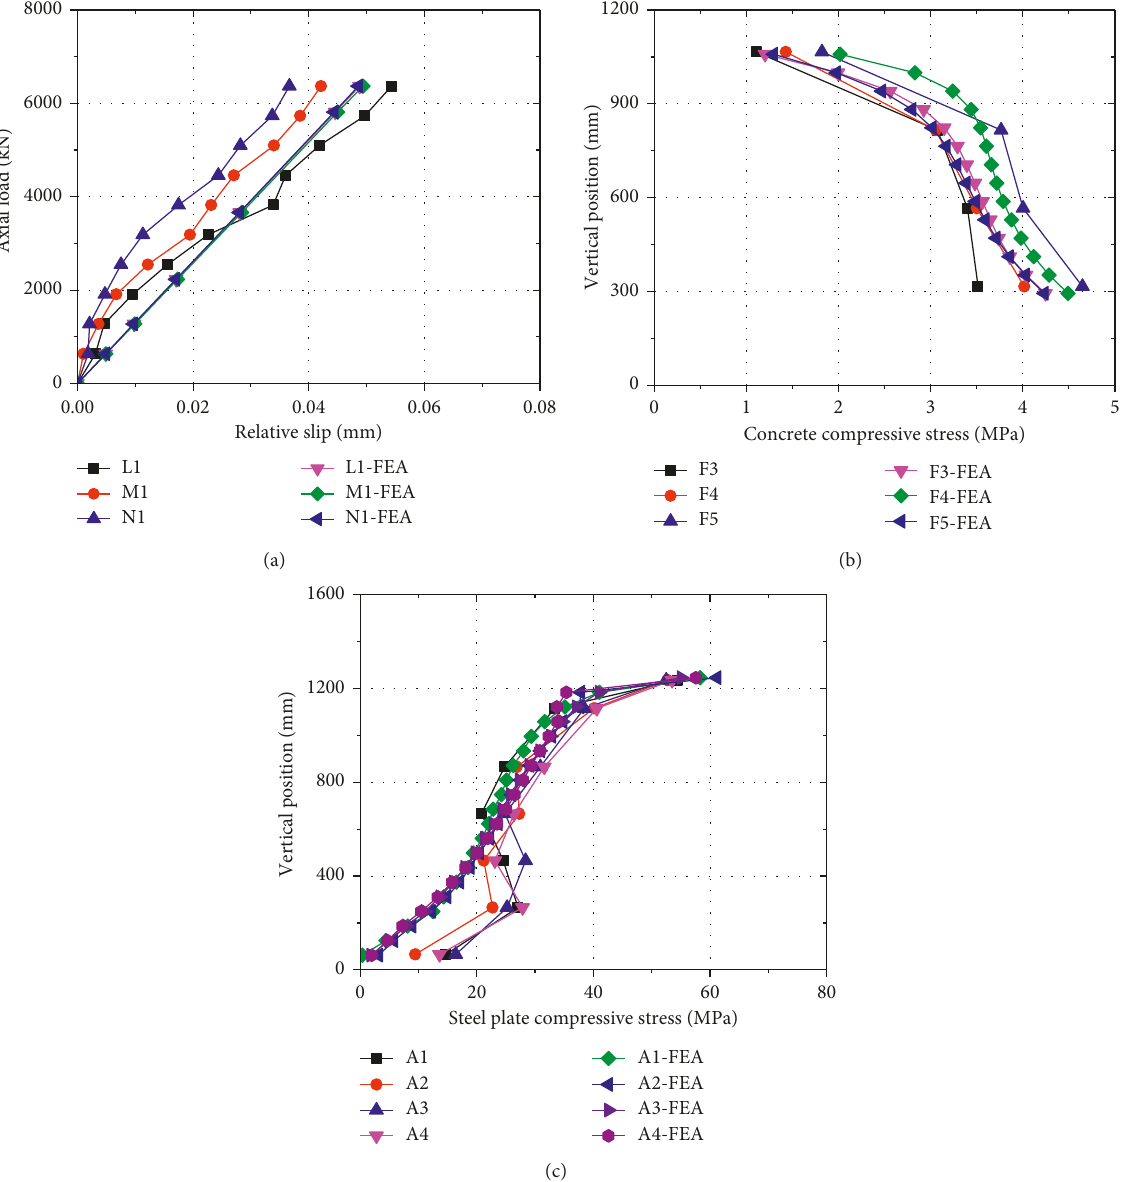
Figure 13: Comparison between FEA and model test